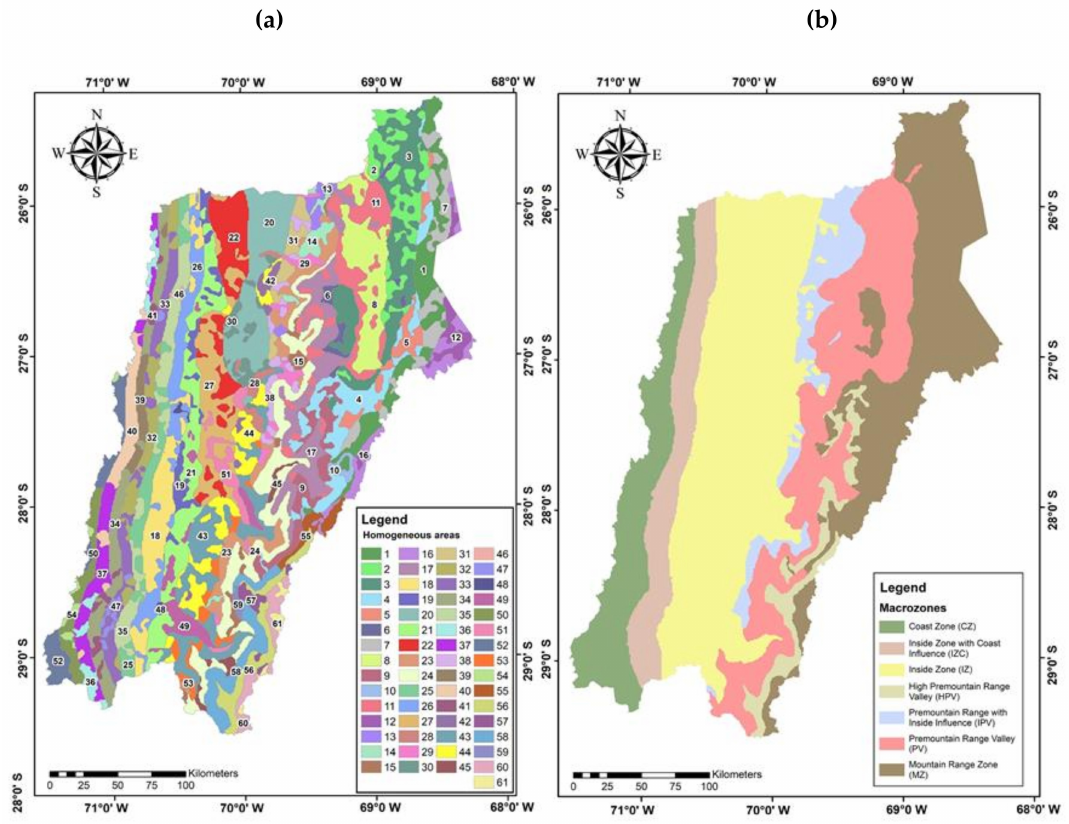
Figure 6. ( a ) Cartography of topoclimatic zoning from a combination of climatic and topographic cartographies. ( b ) Macrozones of the Atacama region that were used to characterize the